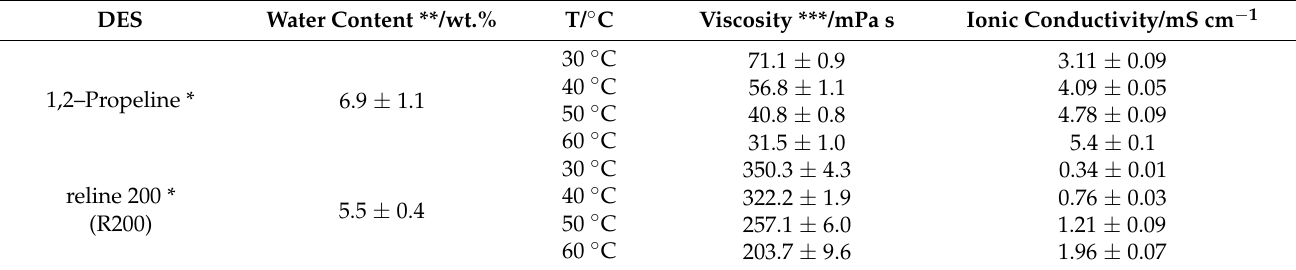
Table 2. Water content, dynamic viscosity and ionic conductivity for 1,2–propeline and reline 200. DES Water Content